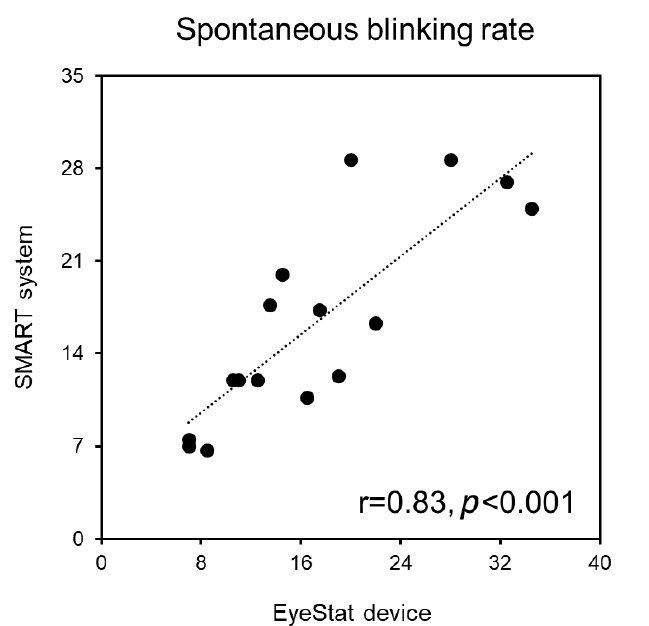
Figure 3. Correlation between the blink rate as measured with the two different methodologies. The axes display the blink rate, as measured by the number of spontaneous blinks per minute. The blink rate recorded during spontaneous blinking with the EyeStat device significantly correlated with that recorded using the SMART system.